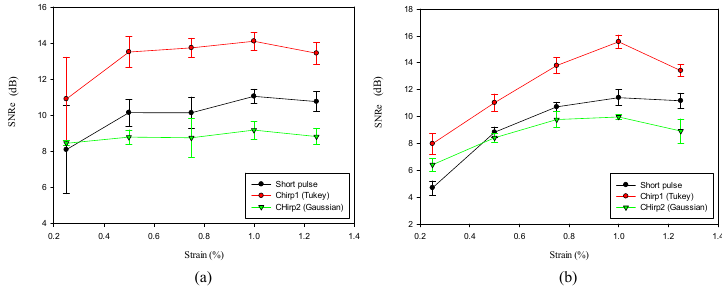
Figure 18. SNRe for all pulse as a function of applied strain. Algorithm for ( a ) AD and ( b ) CC. The correlation window length is 0.77 mm. The pulse length of chirp is 20 cycle.